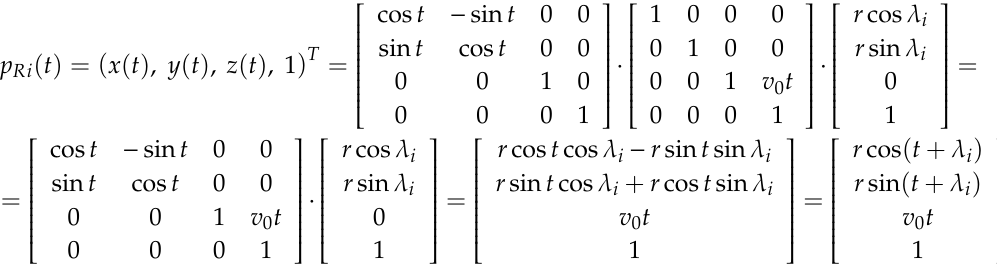
Figure 5. Initial points of the winding right-handed helices p Ri ( left ) and with rotation angle ψ ( right )